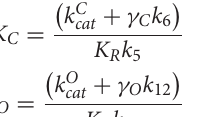
TABLE 2 | Linear regressions of K M or ln( K M ) on k cat for various data sets of sample size N : Coefficients of y -intercept, K M or ln( K M ), and x -variable (gradient), k cat , with standard errors (SE), P -values and 95% ( P = 0.05) confidence intervals.